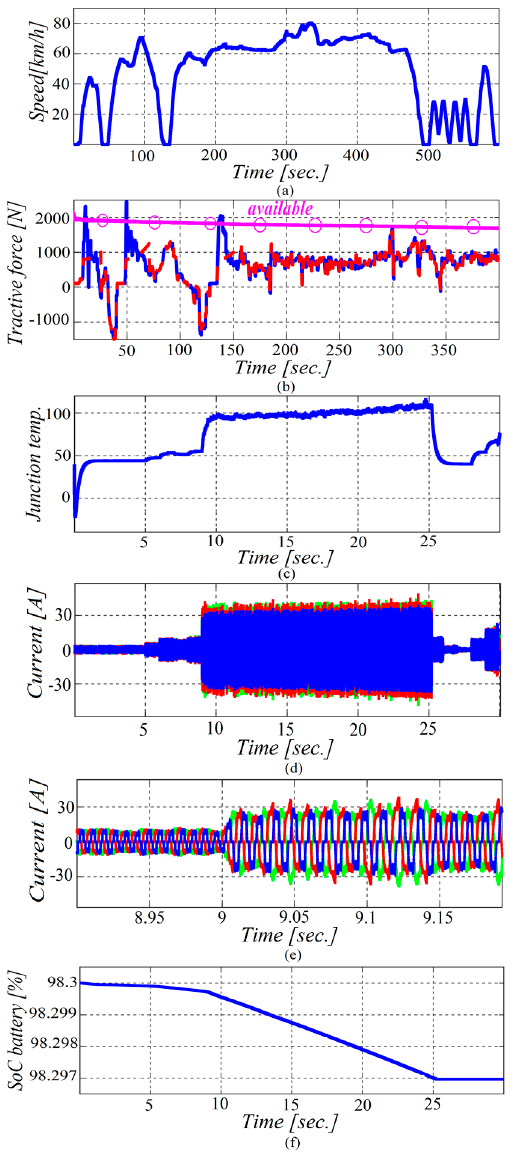
Figure 11. Simulations results with the proposed recommender system (when the driver switches to the safe mode upon request of the recommender system) ( a ) Speed profile during the driving cycle ( b ) Tractive force of the EV ( c ) Junction temperature of the power module ( d ) Motor current ( e ) Zoomed view of the motor current ( f ) SoC of the battery.